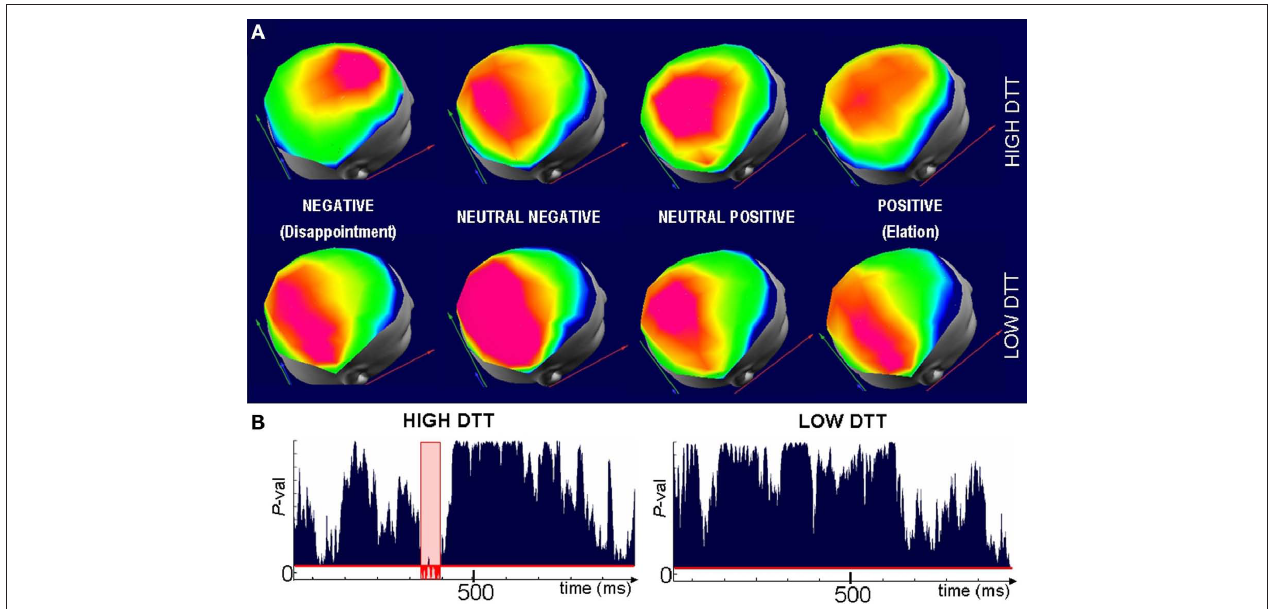
High-DTT which is not significantly different from the map seen for all outcomes in the Low-DTT group. (B) Randomized MANOVA reveals that the fronto-central map is significantly different ( P < 0.05, in red) from the three other maps of the High-DTT group, whereas no significant differences are observed across outcomes in the Low-DTT group (right). The fact that the difference in scalp topographies appears for the High-DTT group confronted to disappointing outcomes suggest that cognitive control over the automatic impulsive reaction is the source of their better performance in the task (higher gains for similar